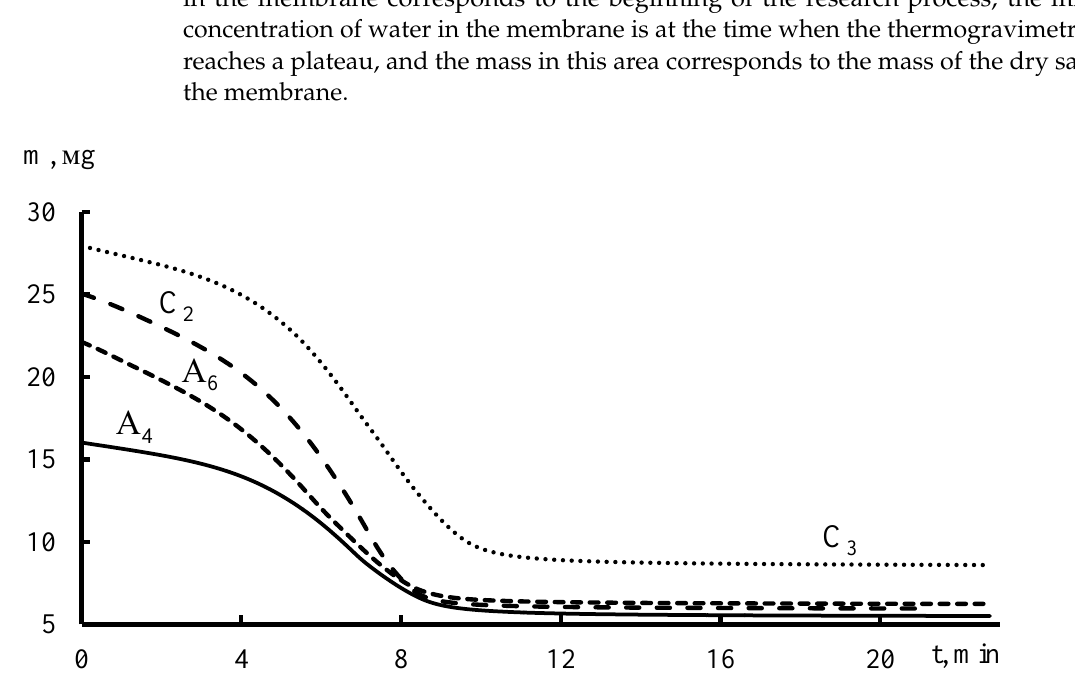
Figure 9. Dynamic change in the mass of wet samples at a heating rate of 10 ◦